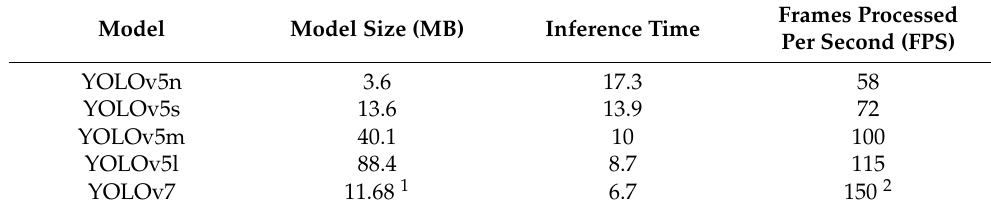
Table 3. The sizes, inference and FPS of different models.